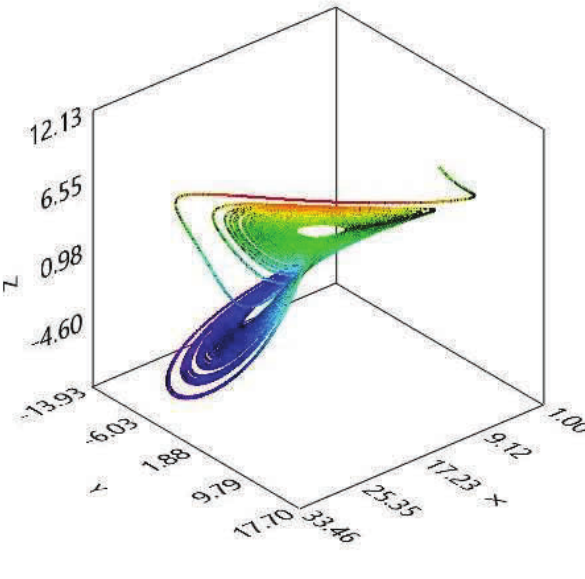
Fig. 1: 3D State portrait of the Fractional order System (2).